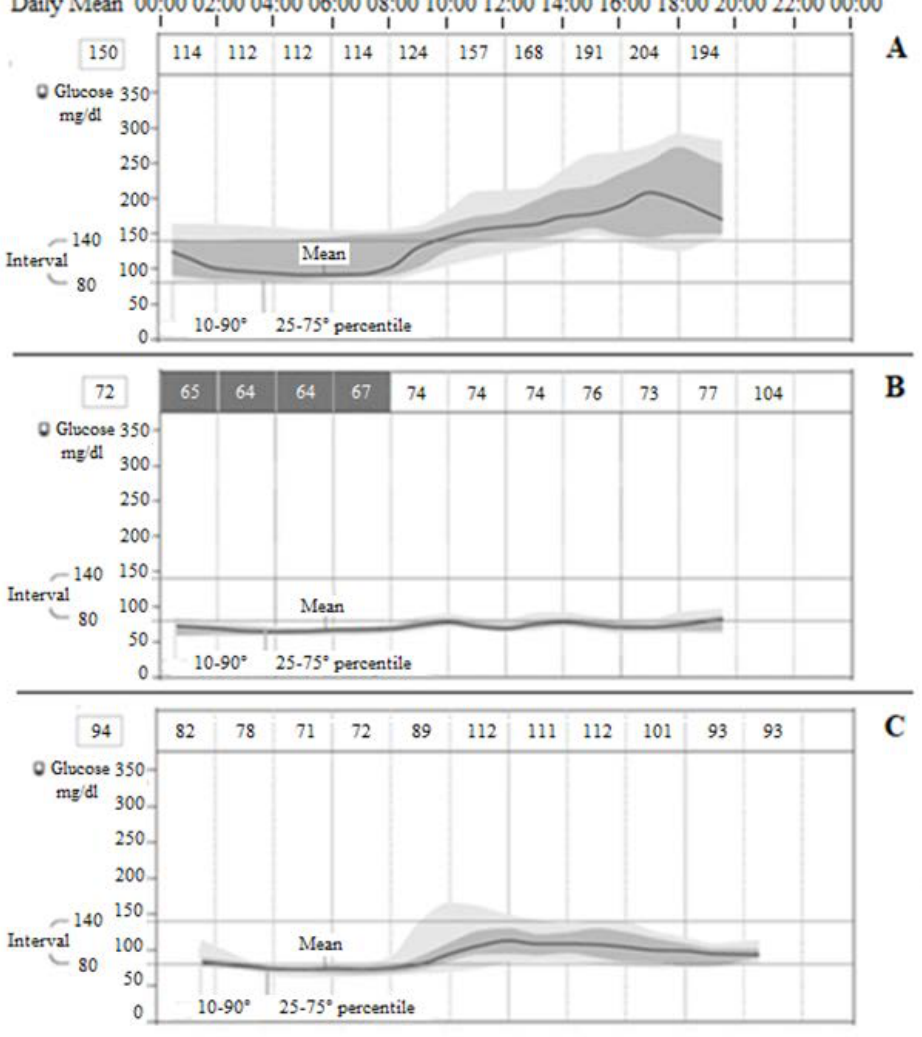
Figure 3. Continuous glucose monitoring in selected cases (n=3). A ) Patient A, 81 years, MMSE=1.5, NPI=77, Cornell=13, CAM-S=17, HbA1c=6.6%, glucose mean 150 mg/dl, above/in/under the interval 56/43/1%, event of low glucose=0, mean duration=0 , mean duration=0 min. B ) Patient B, 77 years, MMSE=13.7, NPI=30, Cornell=12, CAM-S=4, HbA1c=5.5%, glucose mean 72 mg/dl, above/in/under the interval 0/16/84%, event of low glucose=26, mean duration=296 min. C ) Patient C, 82 years, MMSE=10.5, NPI=52,